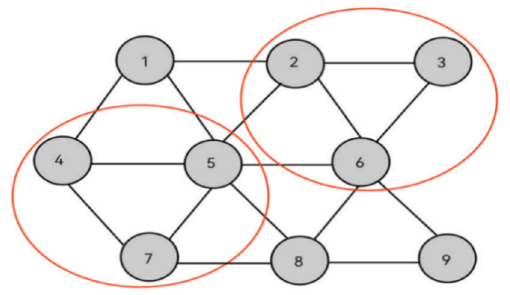
Figure 3. Intercell interference graph clustering.